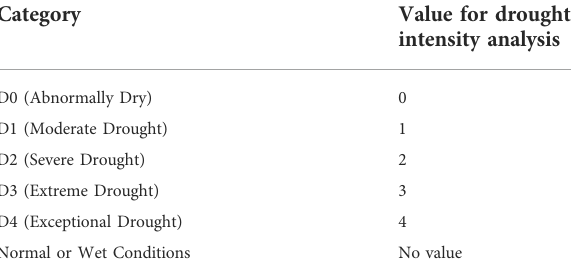
TABLE 5 Pixel values in drought intensity